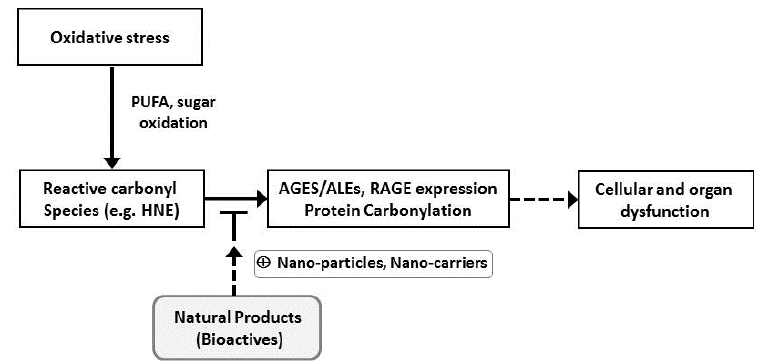
Figure 2. Hypothetical cytotoxic reactive carbonyl species sequestering action of natural products. PUFA, polyunsaturated fatty acid; HNE, 4-hydroxy- trans -2-nonenal; AGEs/ALEs, advanced glycation end product/advanced lipoxidation end products; RAGE, receptor for advanced glycation end products.